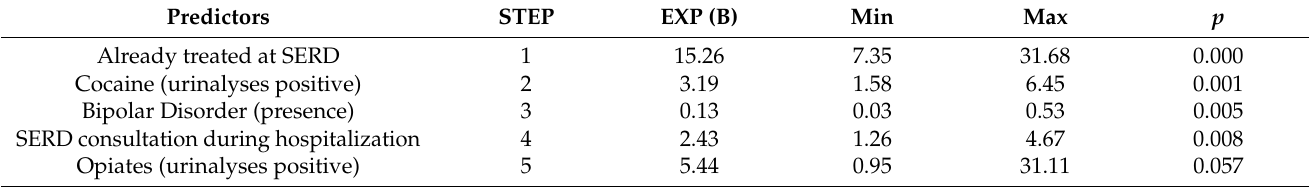
Table 3. Step-wise logistic regression analysis. Patients attended “post-discharge appointments at SERD” is the criterion. Variables showing statistical significance at univariate level are